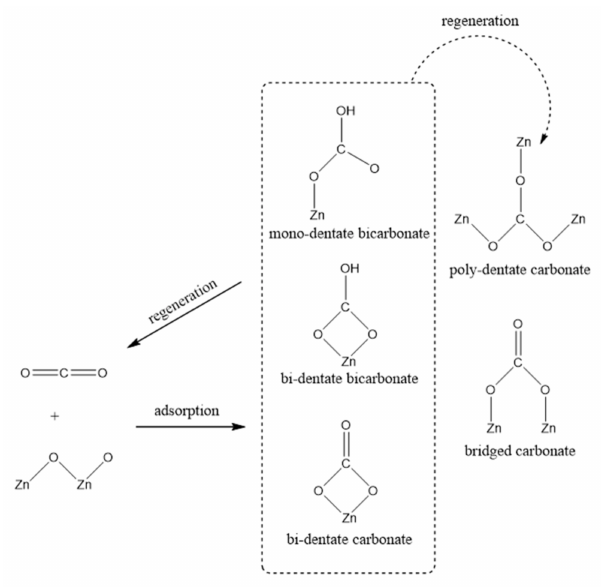
Figure 12. Schematic diagram of CO 2 adsorption and